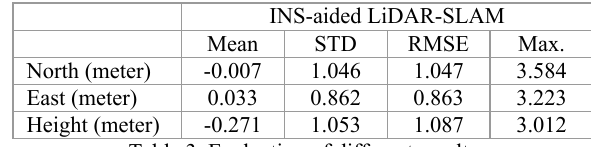
Table 3. Evaluation of different results